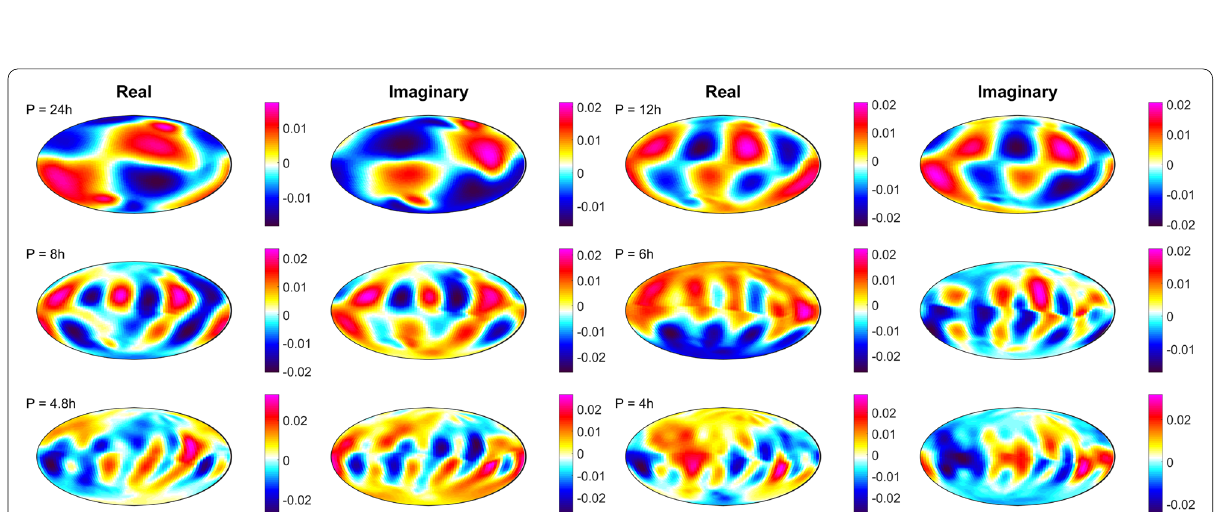
Fig. 8 Maps of the first, dominant mode for each period P 72 h. Both real and imaginary parts are displayed. Scaling is normalized and